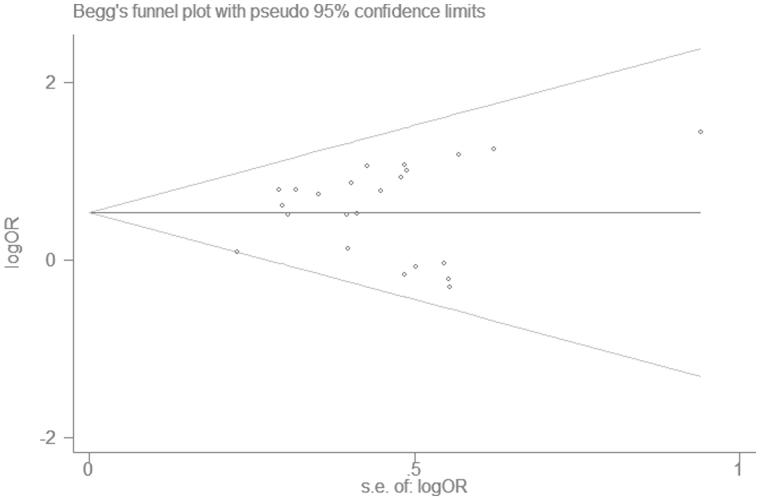
Egger’s funnel plot.